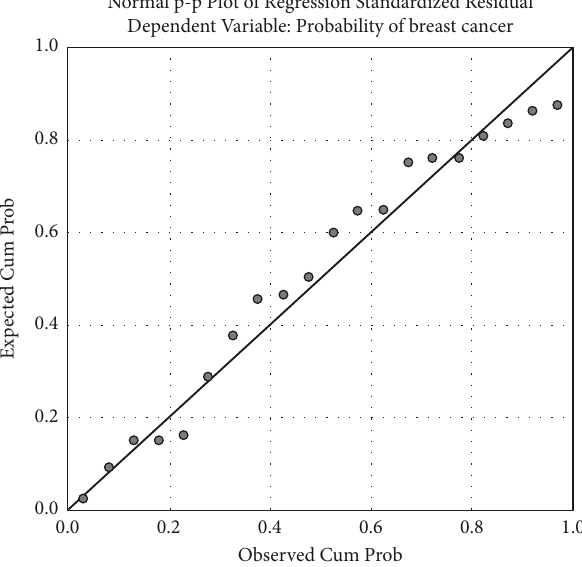
Figure 7: Scatter plot representation of regression